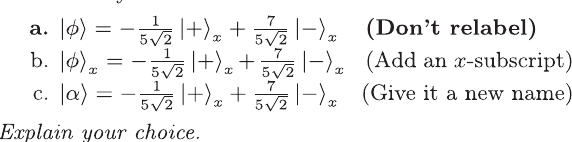
FIG. 1. Q4 from Table I, repeated here for convenience. When considering whether changing basis involves relabeling the state vector, students may either (a) not relabel; (b) relabel by adding a subscript to the ket; (c) relabel by using a new symbol inside the ket. The correct answer is